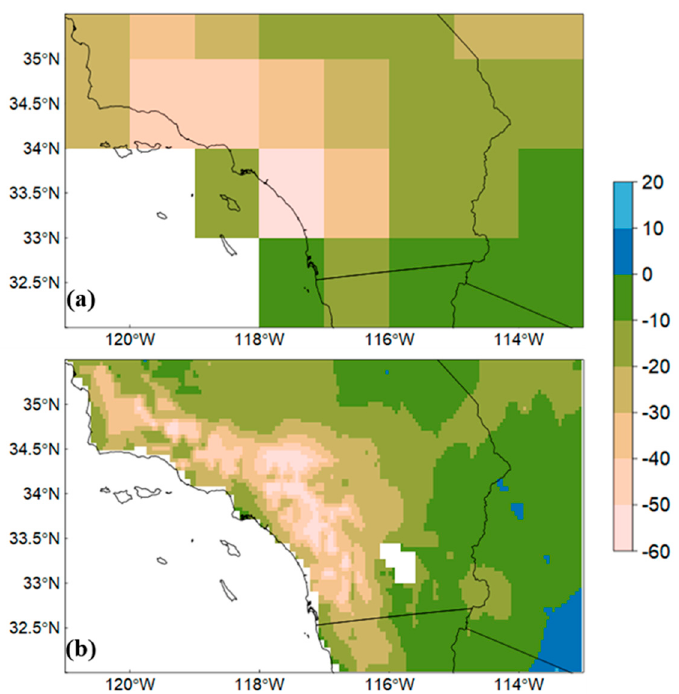
Figure 5. 2007–2016 average monthly TWS anomaly for ( a ) GRACE and ( b ) SSIB-SIMGM. Anomalies calculated based on the 2007–2010 average baseline. Unit: mm.